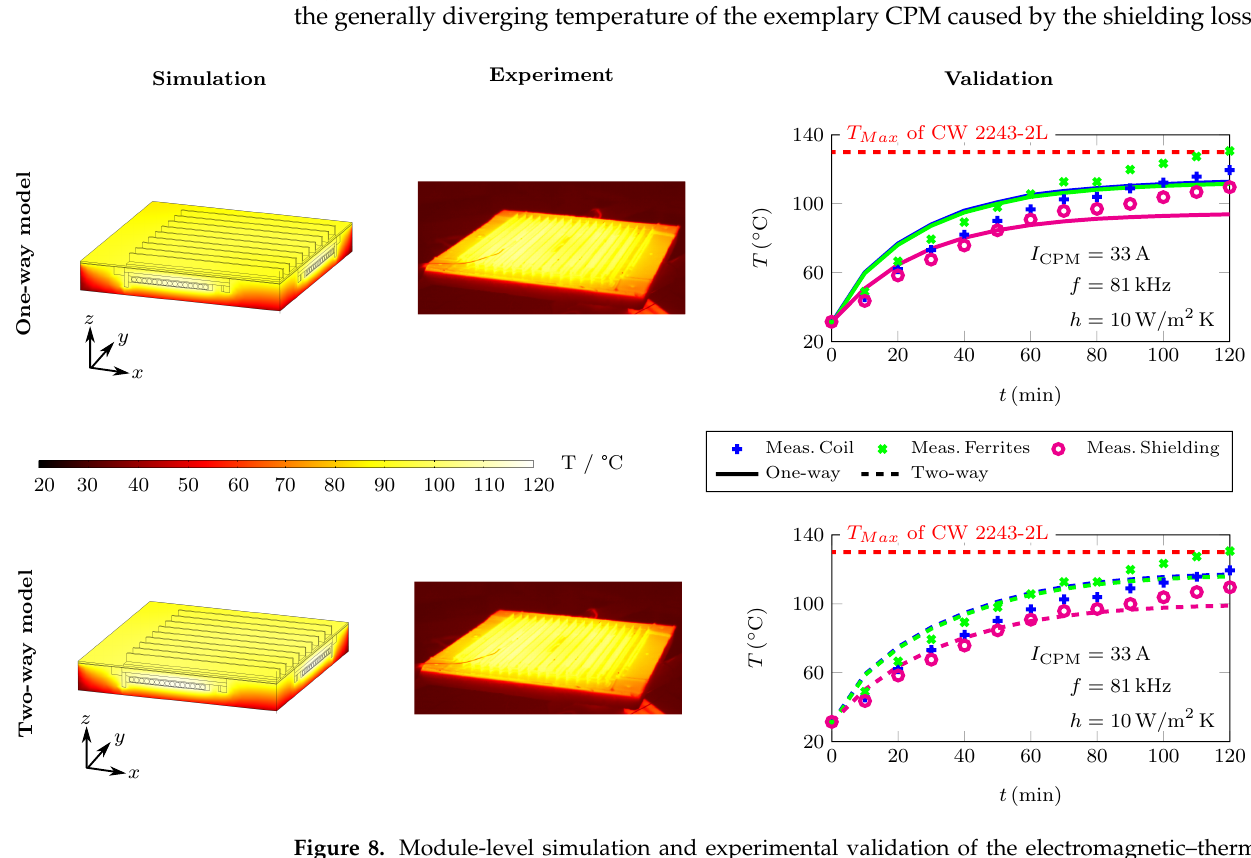
Figure 8. Module-level simulation and experimental validation of the electromagnetic–thermal simulation models’ transient and steady-state behavior. The thermographic images were taken for comparison after the maximum operation time.